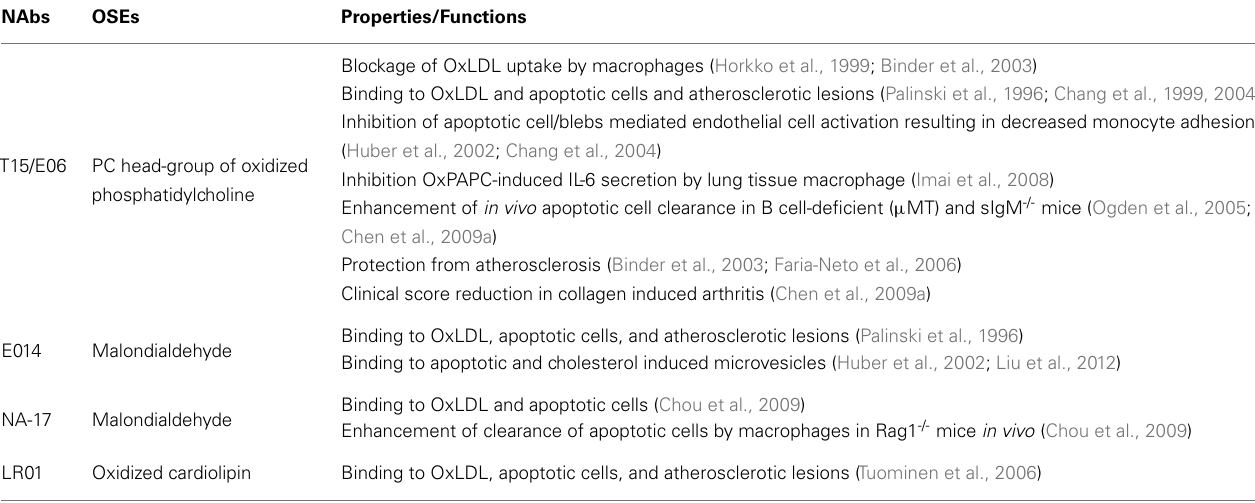
Table 1 | Natural IgM antibodies recognize oxidation-specific epitopes present on apoptotic cells and OxLDL and modulate their inflammatory